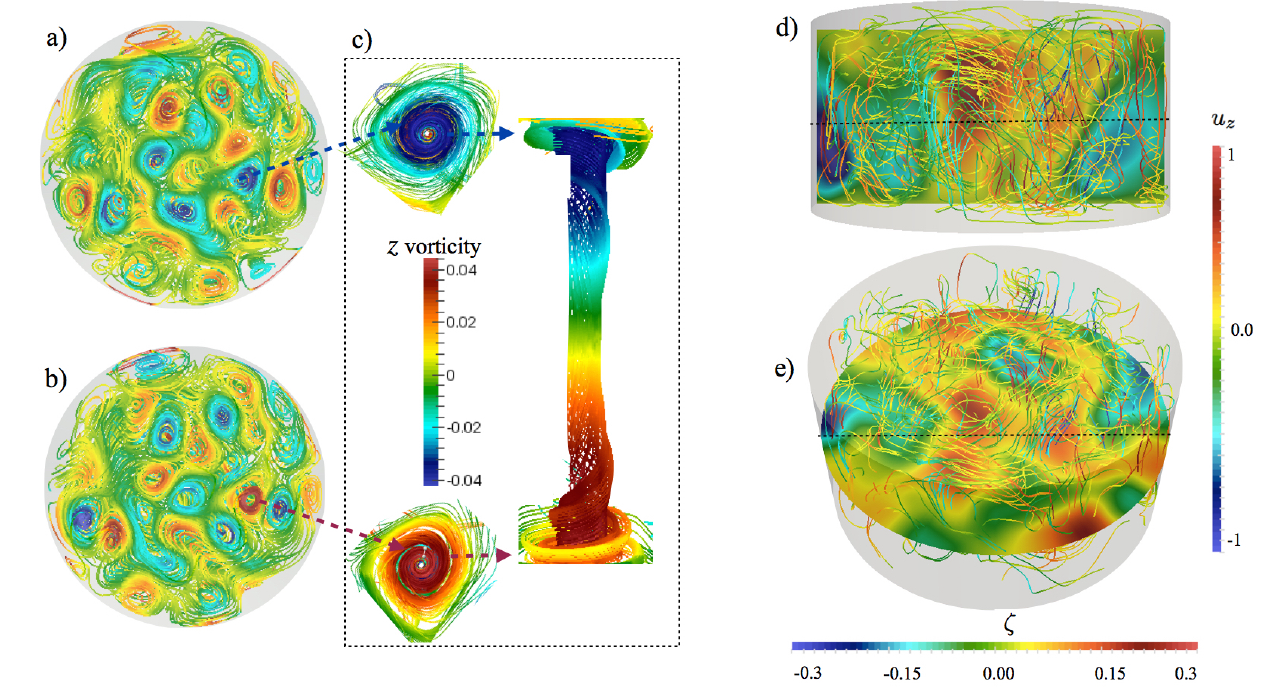
= 1 . 5 ) and RC 3 = 1 . 5 ). ( a , b , c ; t/τ ( d , e ; t/τ κ κ n n color-coded streamlines, similar z